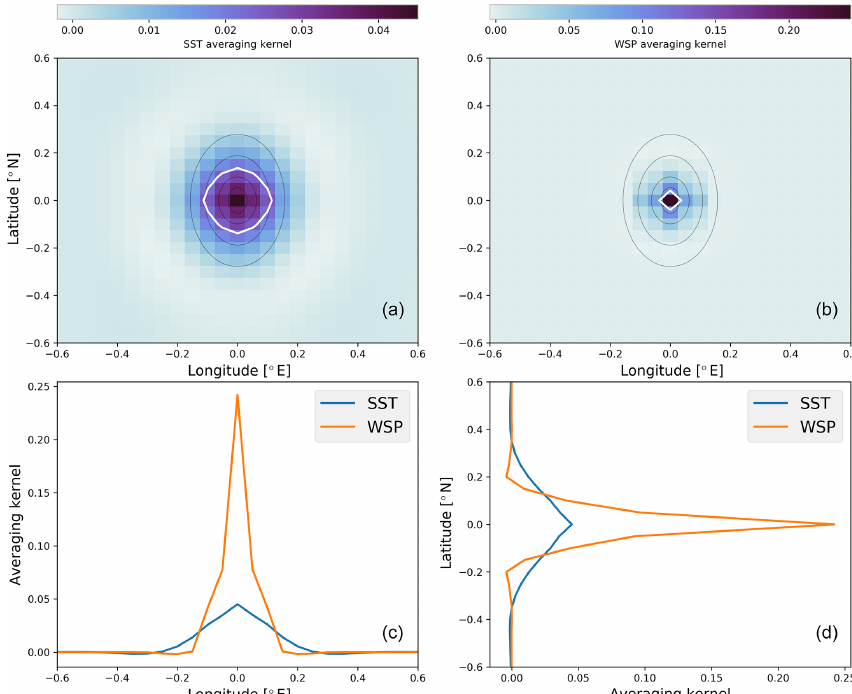
Figure 4. Averaging kernels for a central grid point from the synthetic scene, shown for SST (a) and WSP (b) , with cross sections through the maxima given in panels (c) and (d) . Overlaid on panels (a) and (b) are the FOVs for 6, 10, 18, and 36GHz channels (in black) along with a white line indicating the half power contour of the averaging